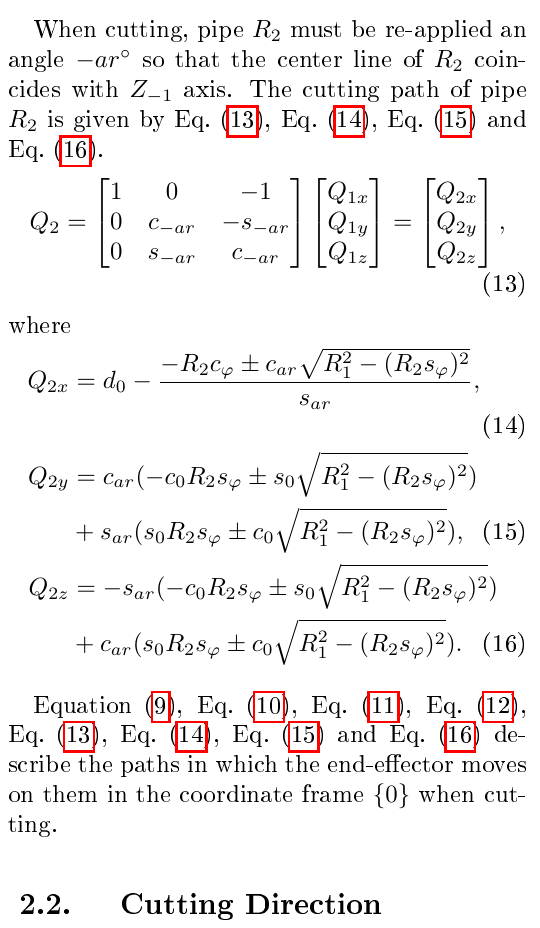
Fig. 2: Cutting direction of pipe R 1